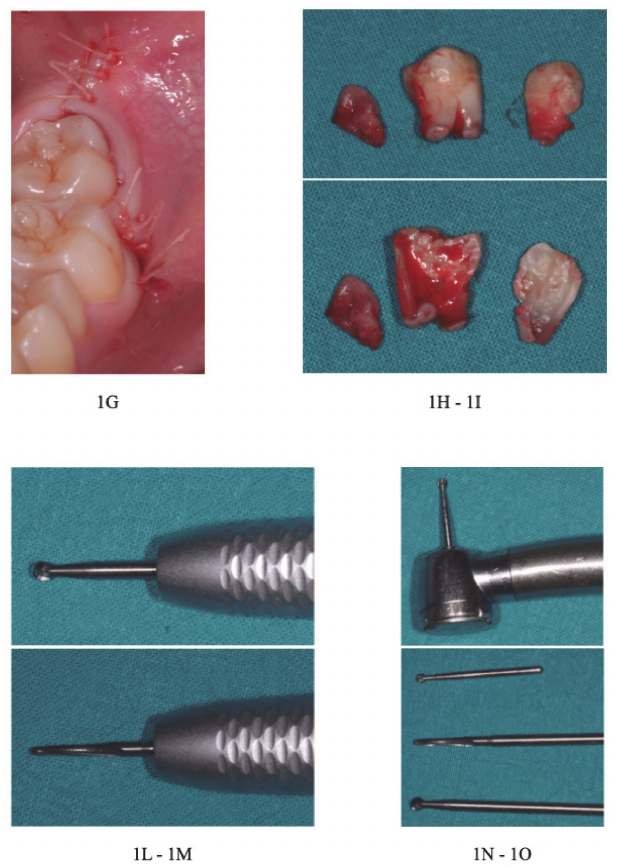
Figure 1. ( A ) Clinical examination; ( B ) flap incision; ( C ) flap elevation; ( D ) ostectomy with ball and fissure burs; ( E ) odontectomy with spherical bur; ( F ) avulsion; ( G ) suture (absorbable suture Ethicon Vicryl, Rapide in polyglactin 910, with a needle 3/8 of 19 mm, USP 3/0—white).; ( H – I ) avulsion of the fragments of the germ; ( L ): straight handpiece with the ball bur; ( M ) straight handpiece with the fissure bur in carbon tungsten; ( N ) high velocity handpiece with spherical bur; ( O ) the ball, fissure and spherical